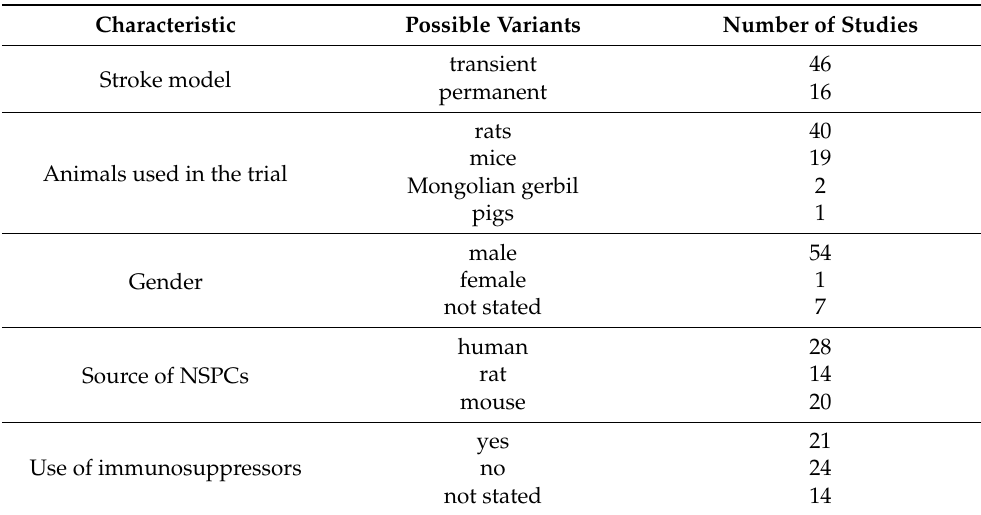
Table 1. Overview of the characteristics reported in the studies included by Huang et al. in their meta-analysis of pre-clinical trials with neural stem progenitor cells (NSPCs) for stroke.